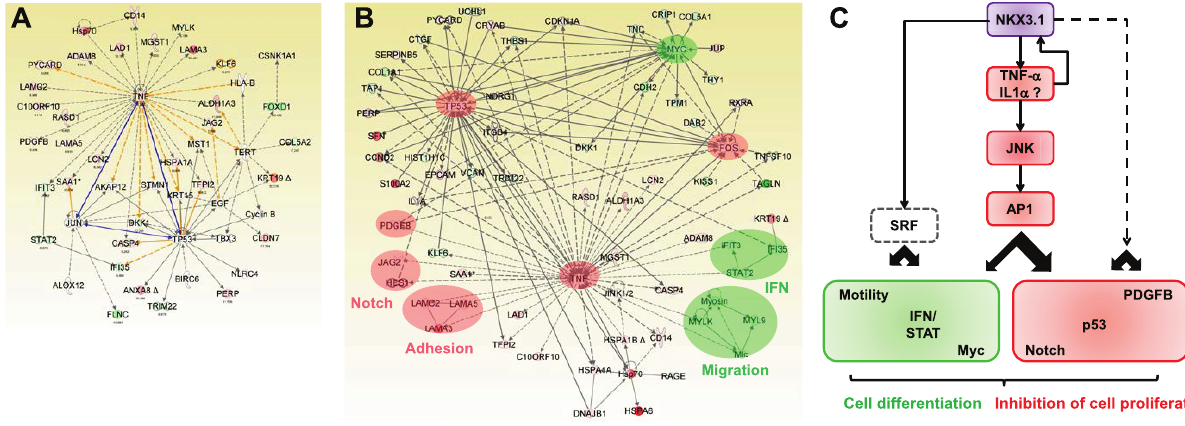
Figure 7. Framework of the NKX3.1 transcriptional program. ( A ) The merged TNF α -p53 network. Network links are highlighted in yellow. Direct edges between TNF α , p53, and JUN are emphasized in blue color. ( B ) Construction of a network containing the major factors implicated in the NKX3.1 transcriptional program, including FOS/AP1, MYC, and p53. Modules activated by NKX3.1 expression are shaded in red and those suppressed in green. ( C ) Tentative framework of NKX3.1-dependent changes to cellular modules. Based on the induction of TNF α and FOS mRNA by NKX3.1, and the antagonistic effects of JNK inhibitors on NKX3.1-mediated gene expression and cell proliferation, the framework proposes that TNF α signaling results in activation of AP1 and modulation of downstream genes and functional modules (red squares symbolize upregulation/activation, green squares downregulation). Additional pathways (stippled lines) may impinge on SRF and other transcription factors (not